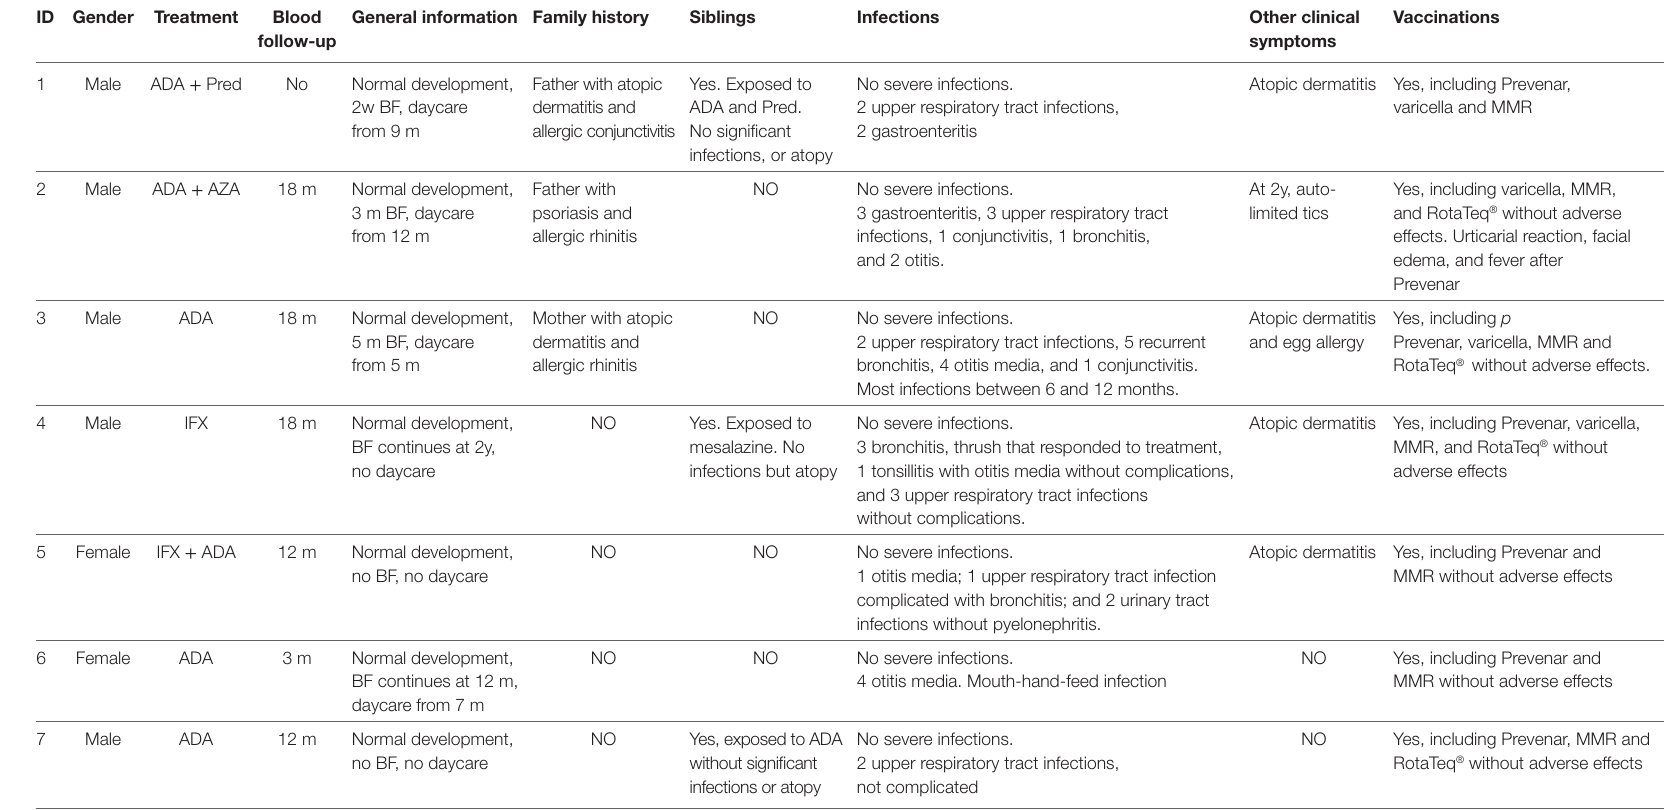
TaBle 4 | Clinical evolution of exposed infants. iD gender